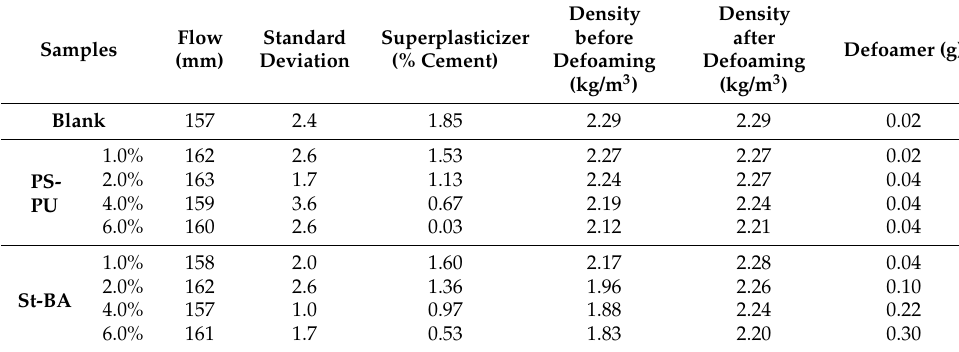
Table 4. Fresh properties of the latex-modified mortar